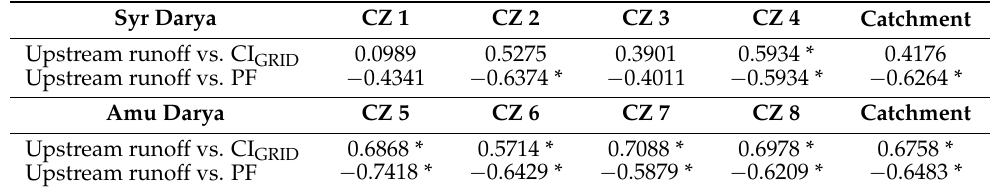
Upstream runoff vs. CI